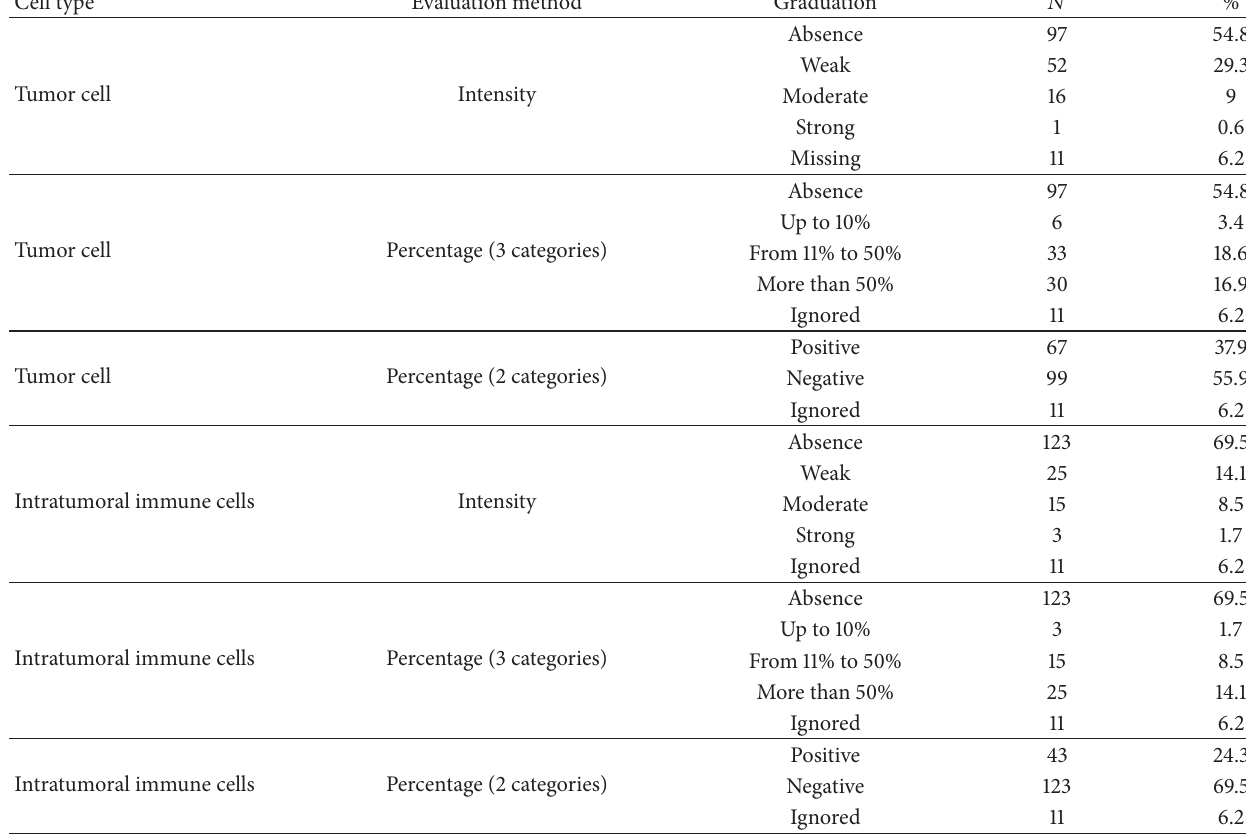
Table 3: PD-L1 expression in conventional histological slides (individual